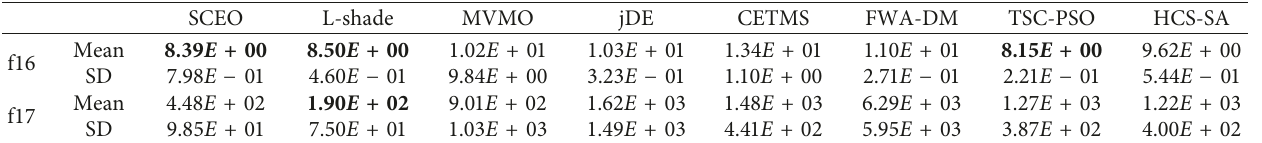
Table 16: Comparison with L-SHADE [36], MVMO [37], jDE [39], CETMS [40], FWA-DM [41], TSC-PSO [42], and HCA-SA [43] algorithms on CEC 2014